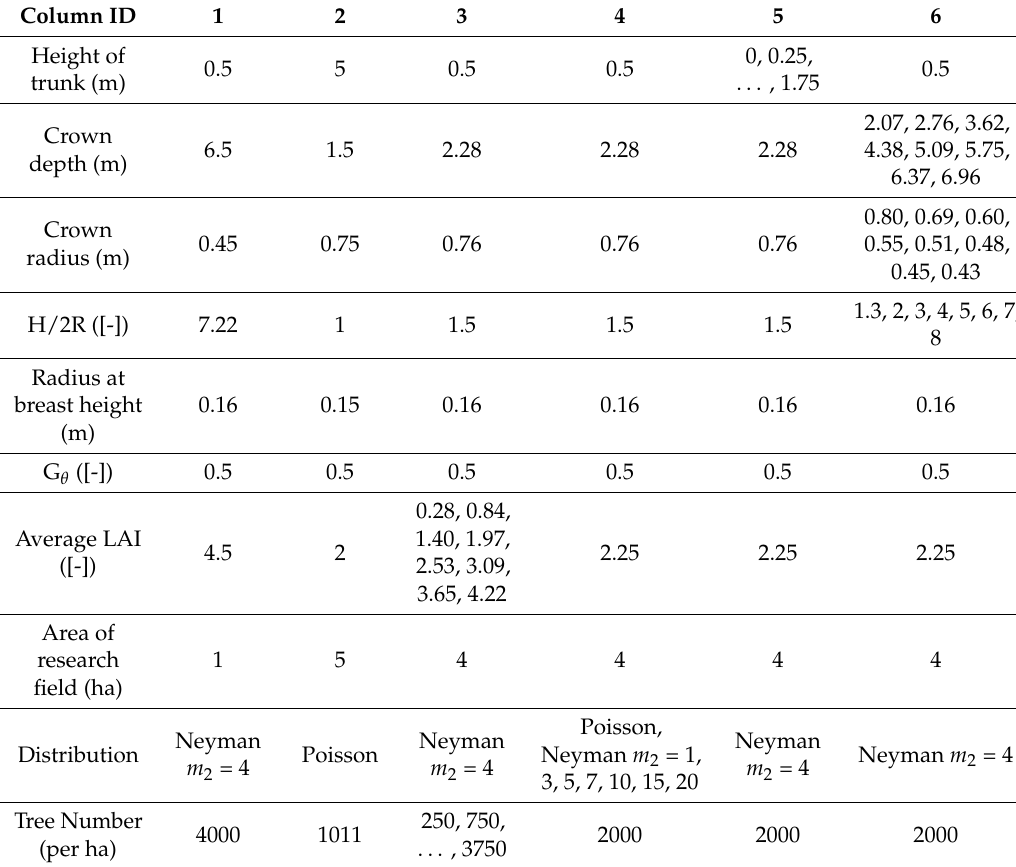
Figure 4. Upward-looking hemispherical photograph and corresponding visual (360°) view of Larch stand. Table 2. Forest structure parameters used in the current paper.